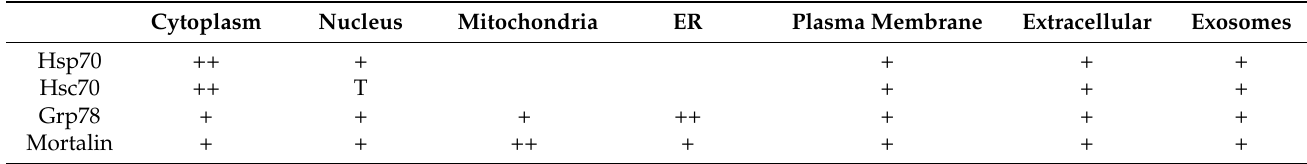
Table 2. Comparison of cellular localizations of HSP70